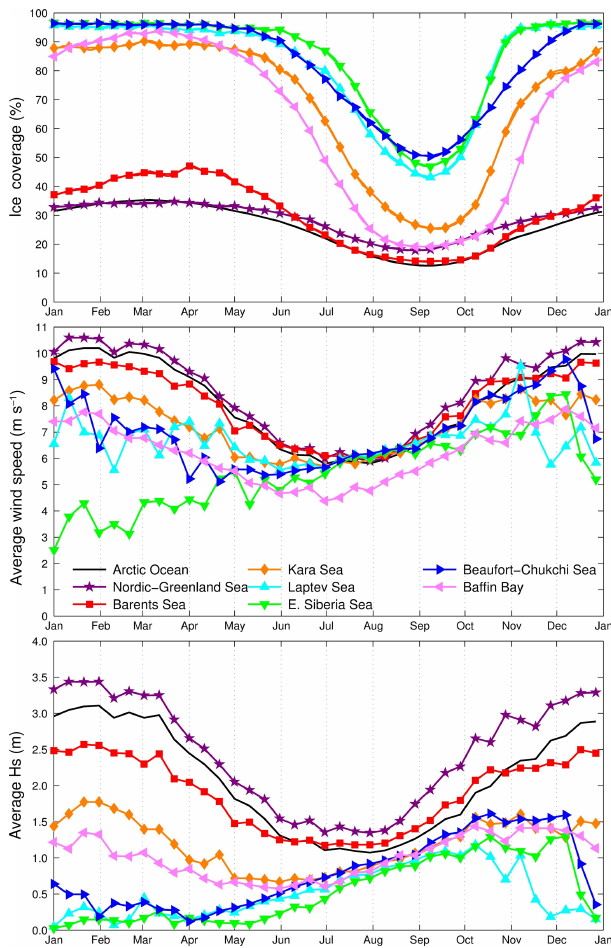
Figure 4. Ice coverage (top), wind speed (middle), and H s daily averages computed from a spatial average for each Arctic region showing the